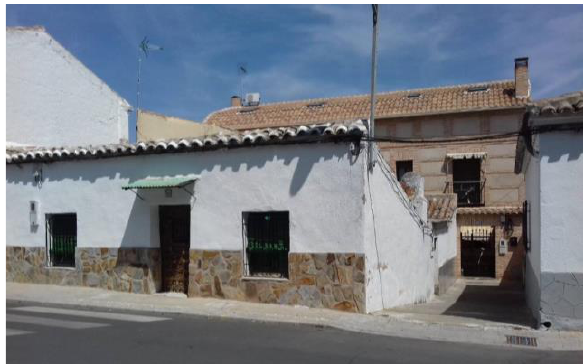
Figure 5. House in Olias del Rey originally accessed through its front enclosed patio and later on transformed to have a new door directly open to the